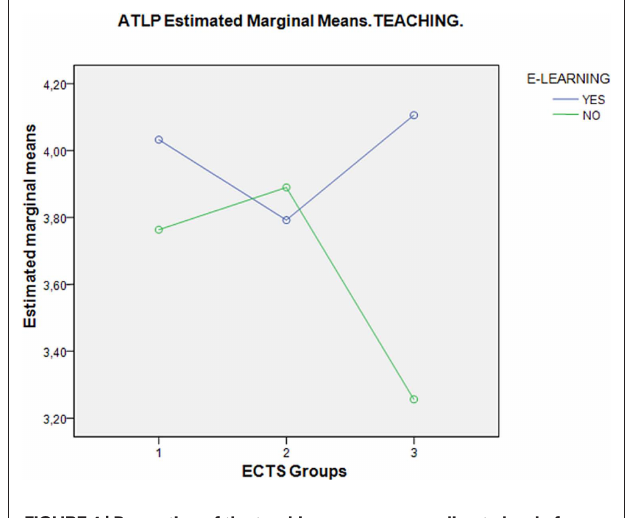
FIguRE 5 | Perception of the learning process, according to level of performance, in class subjects with and without use of e-learning.